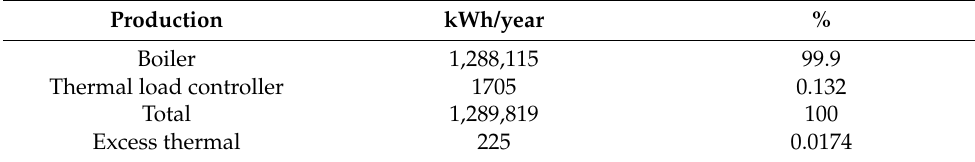
Figure 11. Annual thermal energy production by the system. The integration of the developed system with the local grid station increases the sys- tem reliability and flexibility. Data reported in Table 6 show that during the period of high energy production, the surplus energy is transferred to the grid station at the flat-rate tar- iff, while during the energy deficit period, energy is imported from the local grid station